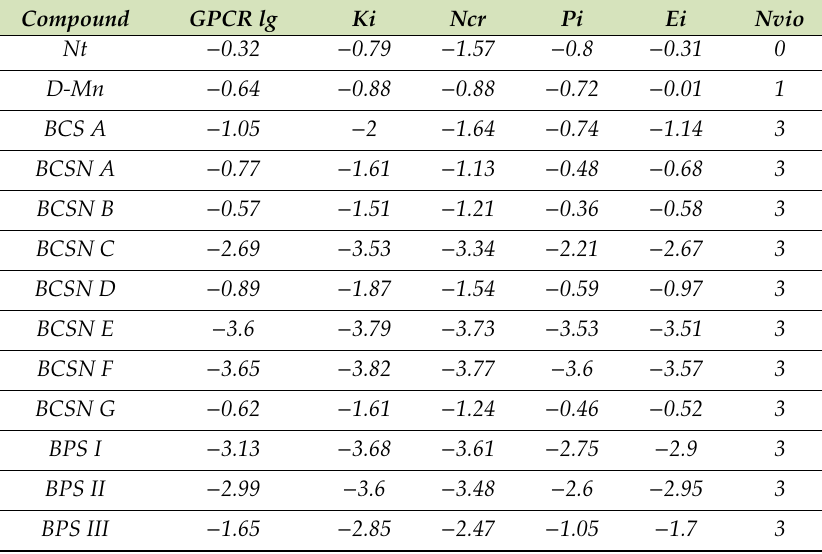
Table 3. Active Compounds and its Features